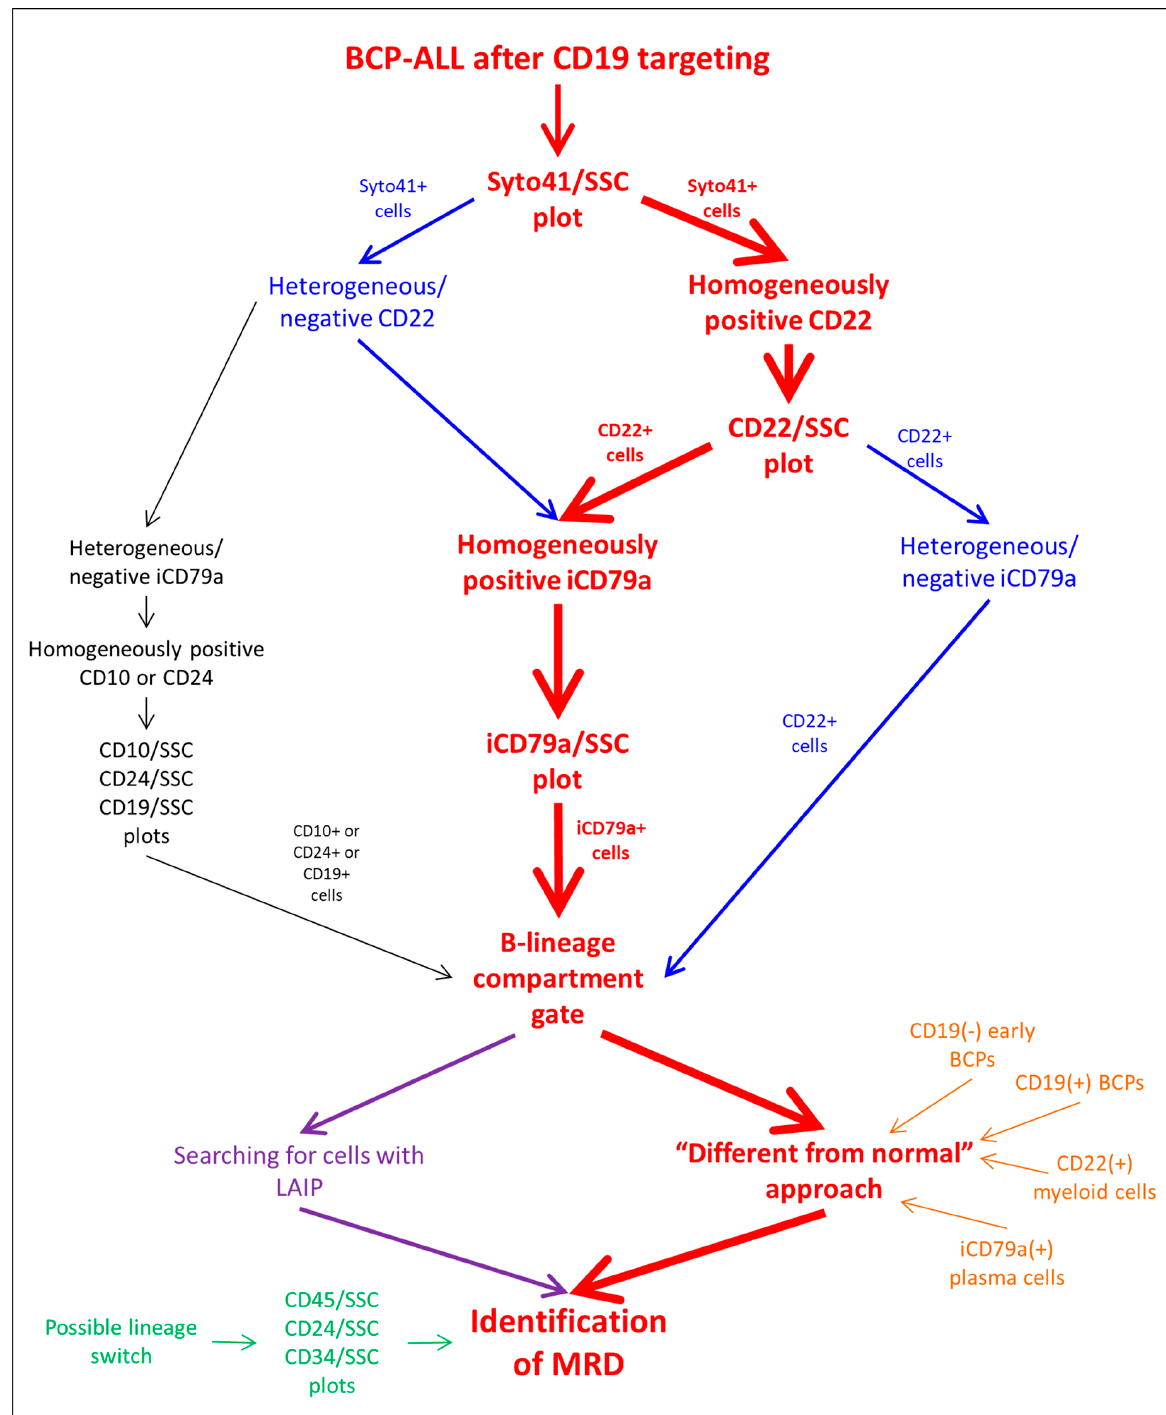
Figure 1. Analysis algorithm of BCP-ALL MRD detection after CD19-directed